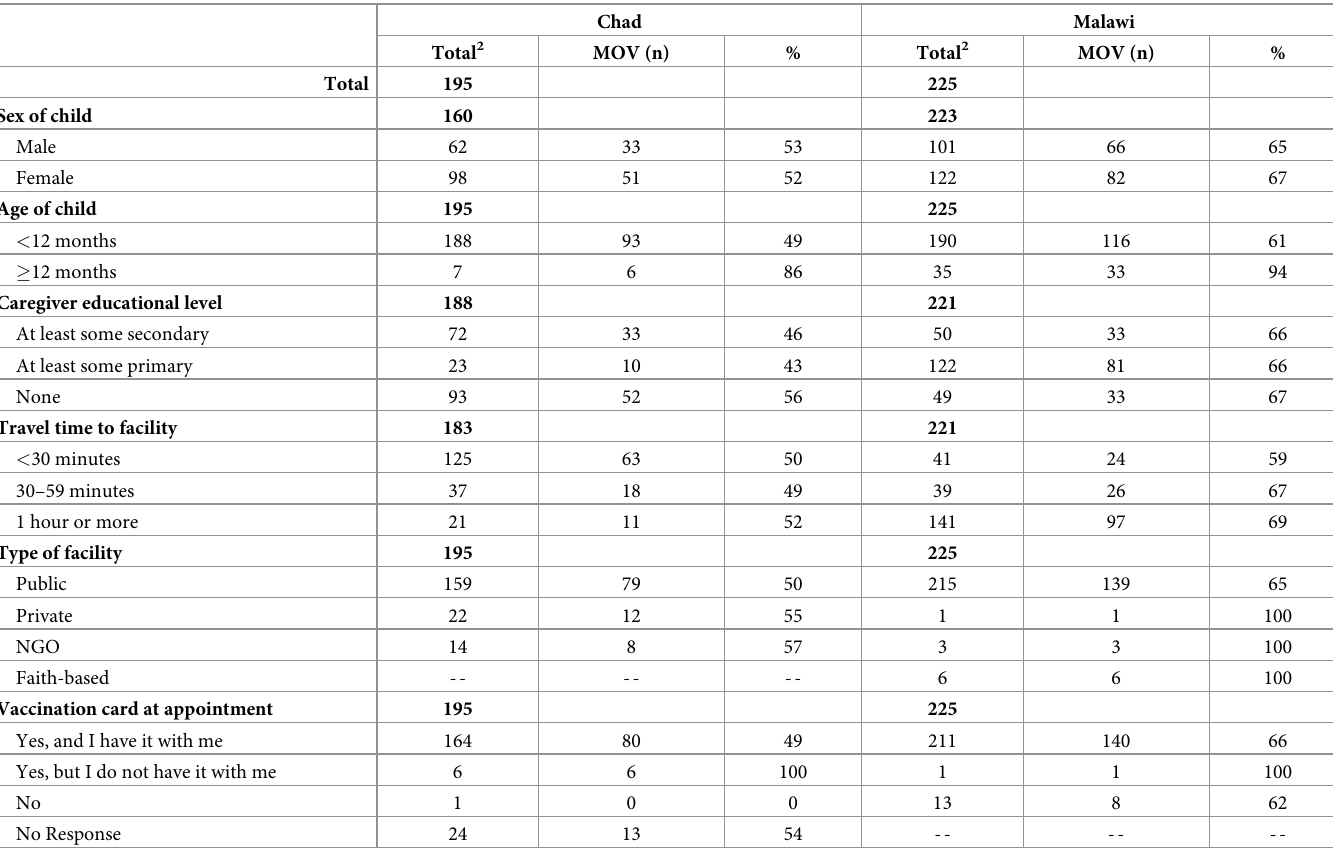
Table 4. Missed opportunities for vaccination (MOV) 1 among children with 1+ eligible doses due stratified by child and caregiver factors: Chad and Malawi,